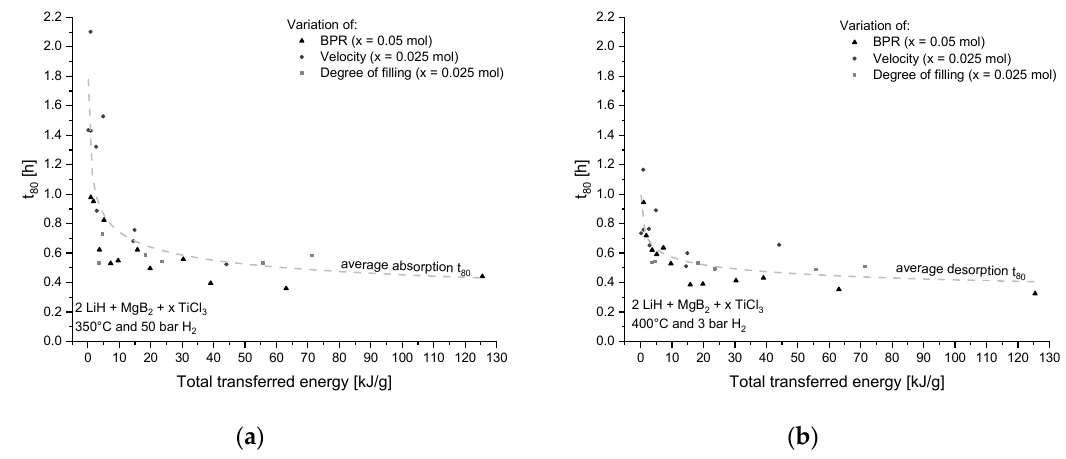
Figure 5. Kinetic behavior as a function of total energy transfer considering different milling parameters for ( a ) absorption and ( b ) desorption.